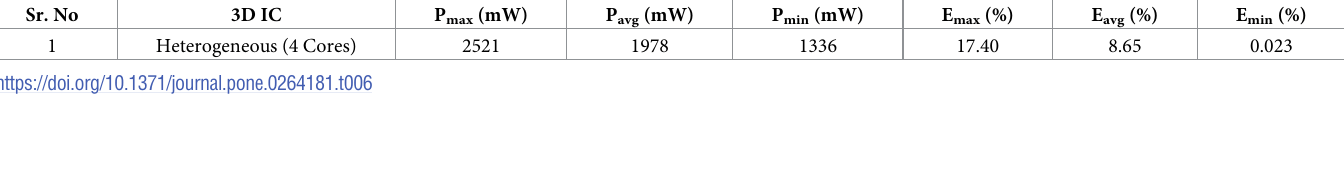
Table 6. Power estimates and accuracy for IP-based heterogeneous 3D IC. Sr. No